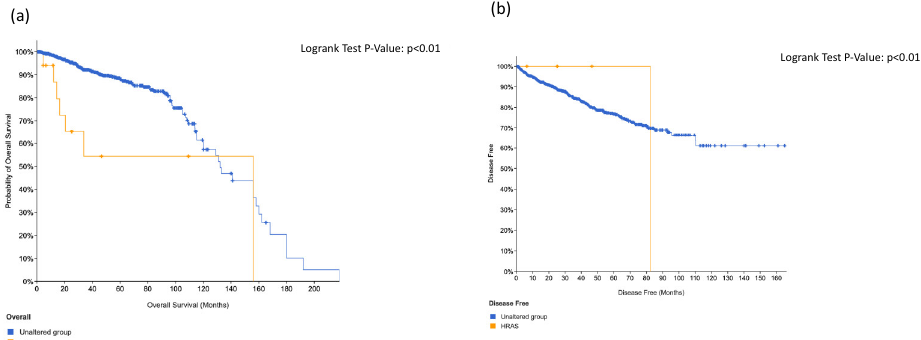
Figure 5. Overall survival ( a ) and disease-free survival ( b ) in KIT-positive prostate cancer patients.